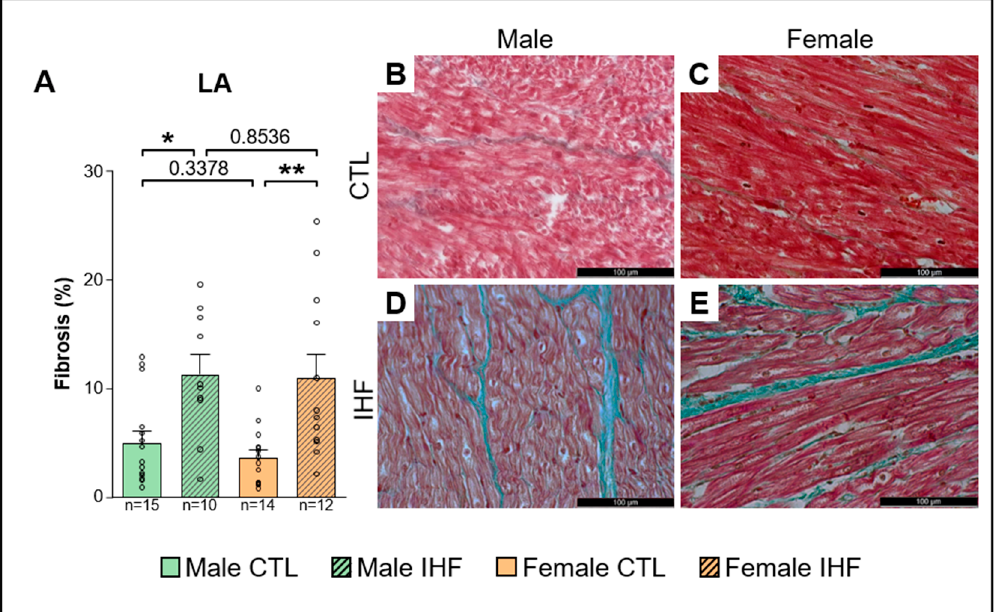
Figure 9. Interstitial fibrosis assessed by Masson‘s trichrome staining in the Left Atrium (LA). ( A ), LA Fibrosis. ( B , C ), Representative images of control pigs in the LA of males ( B ) and females ( C ). ( D , E ), Representative images of IHF pigs in the LA of males ( D ) and females ( E ). CTL , control animals without ischemic heart failure; IHF , animals with ischemic heart failure. Bar graphs represent Mean + SEM, grey circles represent data of individual pigs. Mann-Whitney-U Test. * p < 0.05; ** p < 0.01.